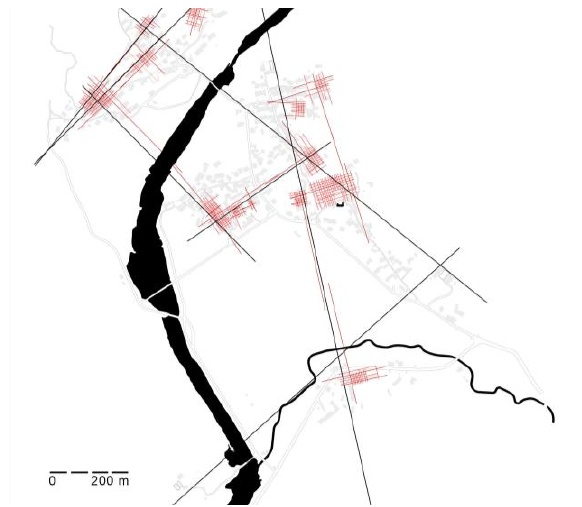
Figure 16. Spatial correspondences of the vernacular architectures. Elaboration by the first author.